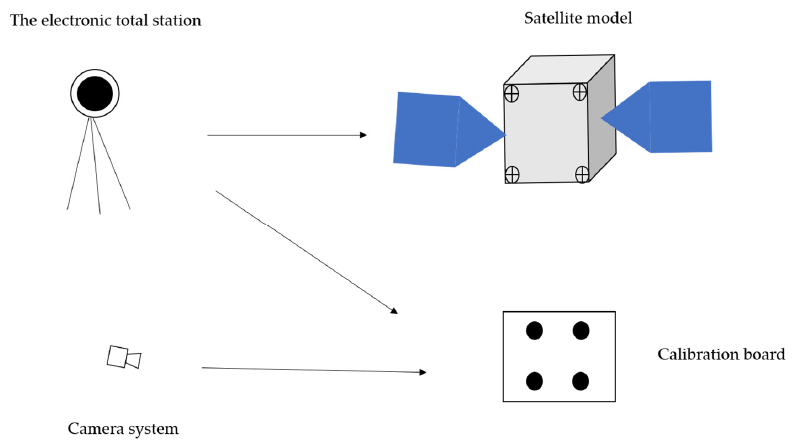
Figure 12. Schematic diagram to verify the accuracy of the ground truth.